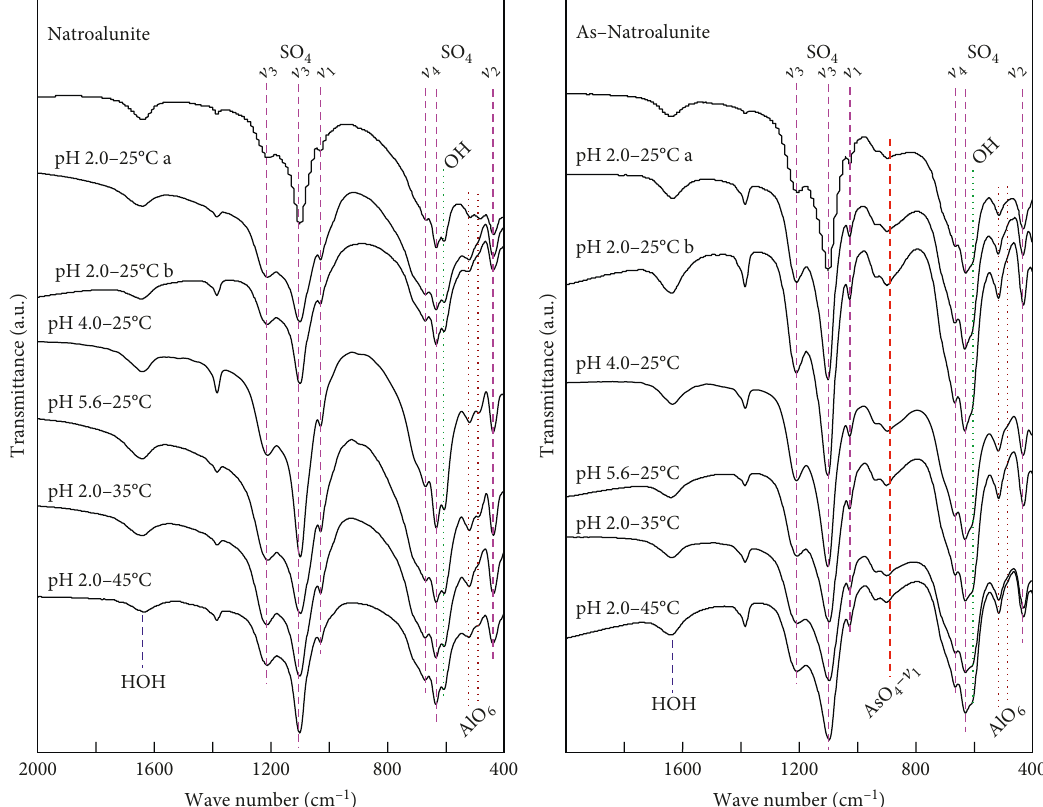
Figure 2: Fourier-transform infrared spectra of the synthetic natroalunite and the synthetic arsenic-incorporated natroalunite before and after dissolution at 25–45 ° C for 300